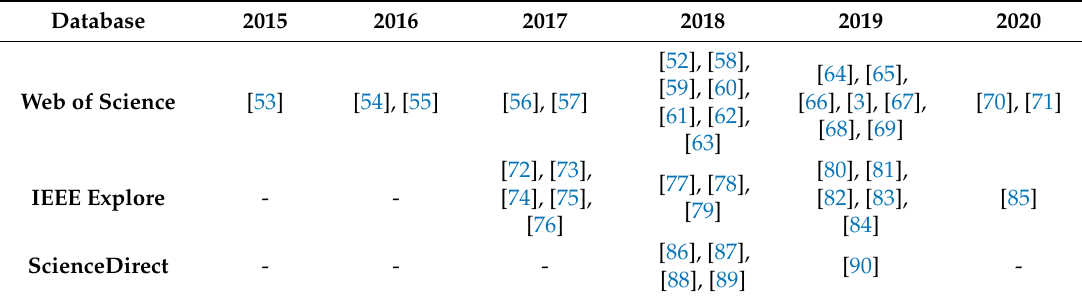
Table 2. Year distribution of included studies from di ff erent databases.